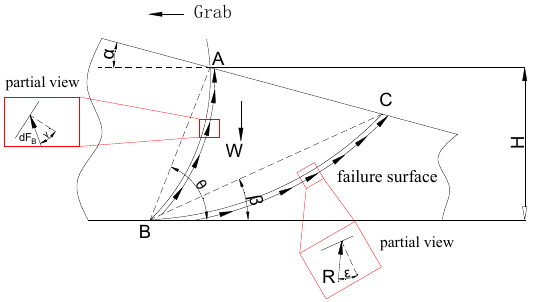
Figure 4. Force diagram of the material body under active pressure.